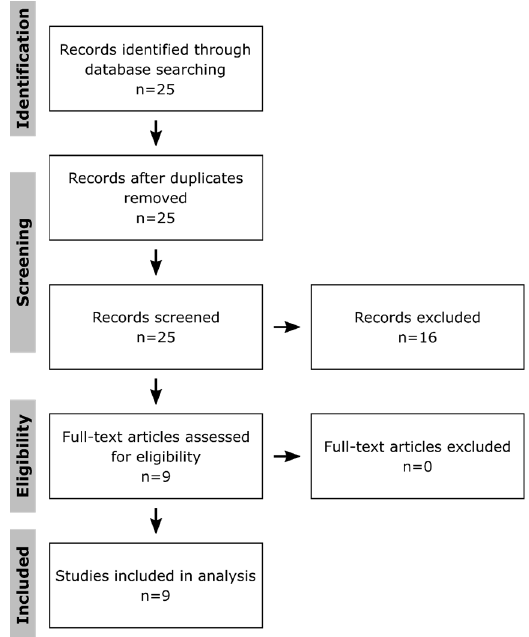
Figure 1. Selection of publications. Shown is the flow diagram according to the PRISMA guidelines [133] for systematic reviews. The publications were selected from the PubMed database, using the terms: “multi omics macrophages toxicity”, “multi omics macrophages toxicology”, “(proteomics AND transcriptomics AND metabolomics) macrophages toxicity”, “(proteomics AND transcriptomics AND metabolomics) macrophages toxicology”, “(proteomics AND transcriptomics) macrophages toxicity”, “(proteomics AND transcriptomics) macrophages toxicology”, “(proteomics AND metabolomics) macrophages toxicity”, “(proteomics AND metabolomics) macrophages toxicology”, “(transcriptomics AND metabolomics) macrophages toxicity”, and “(transcriptomics AND metabolomics) macrophages toxicology” on the 14 July 2020. Only publications describing original research results obtained from at least two omics approaches applied to xenobiotic-treated macrophages were further investigated. Furthermore, only publications using the English language were